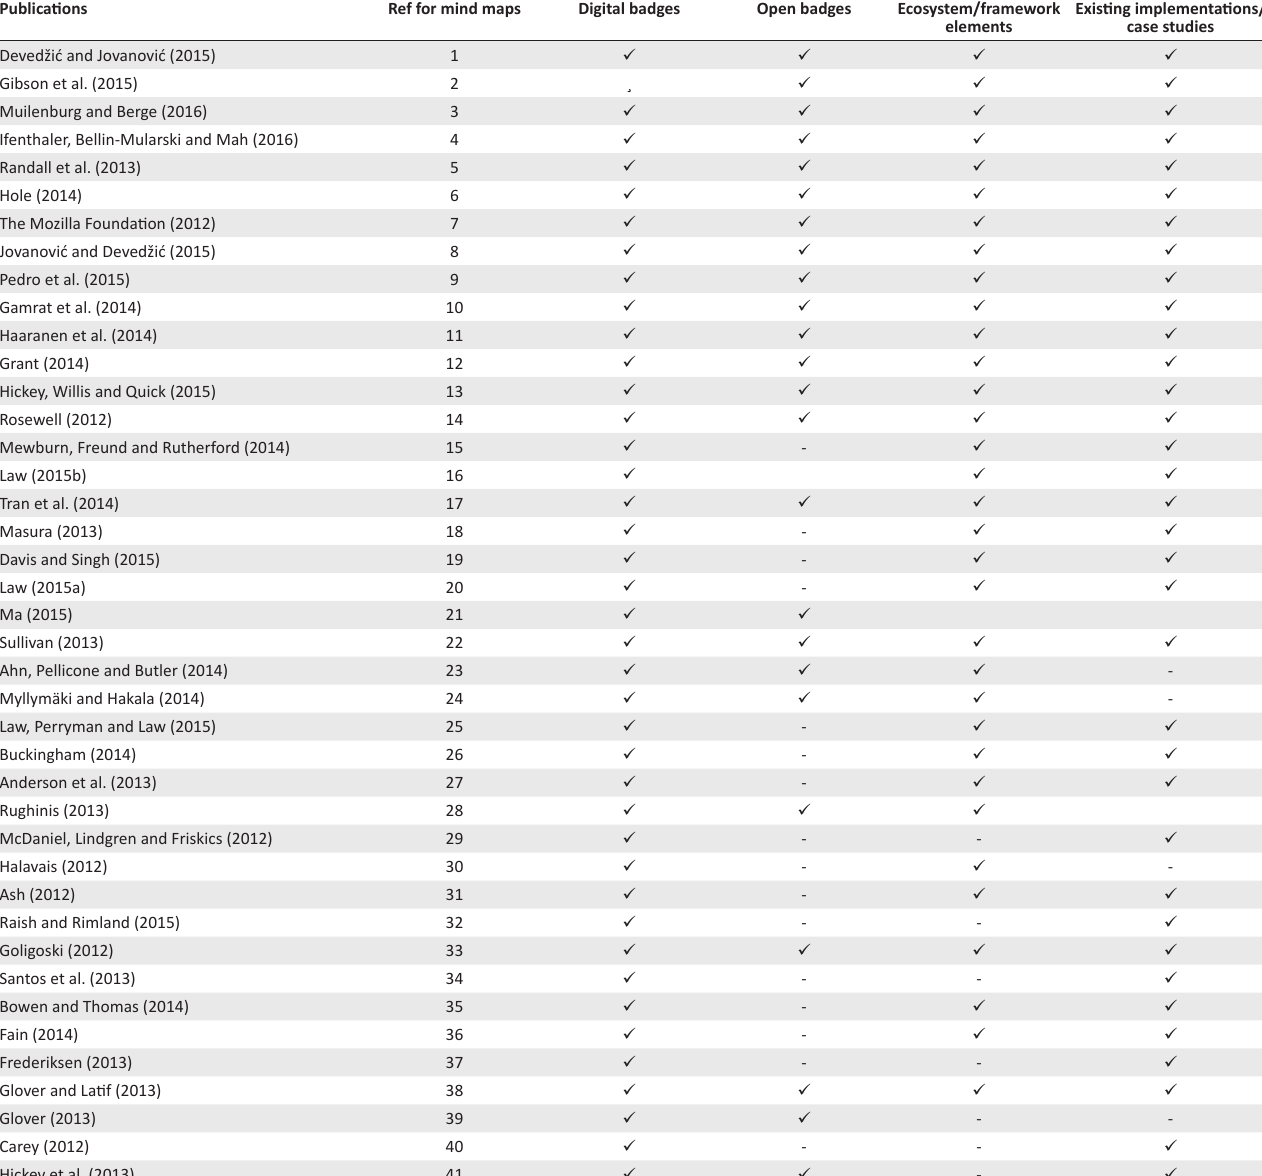
TABLE 5: Summary of publications and focus areas.